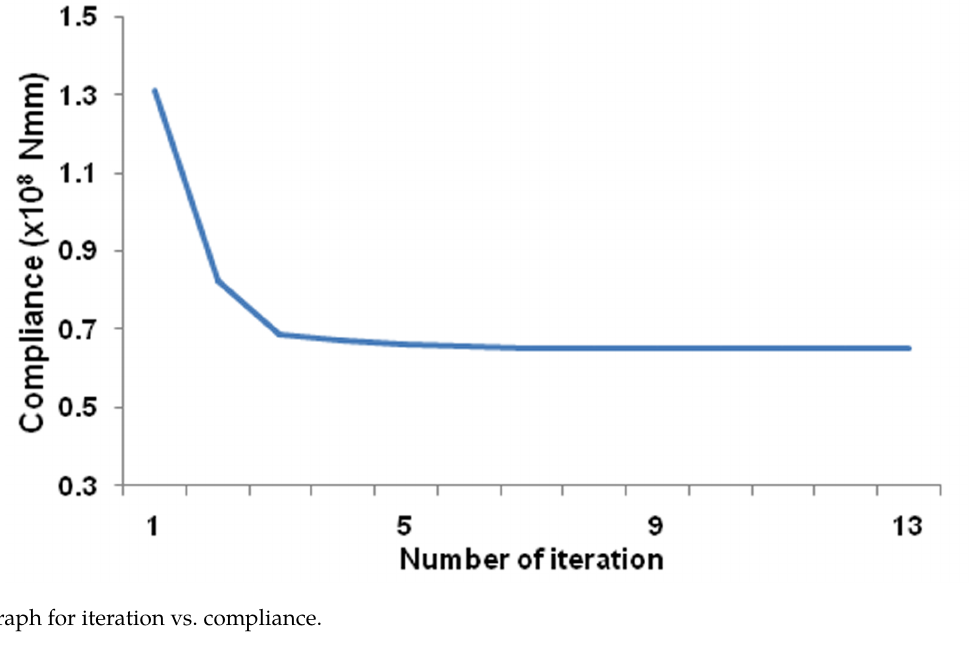
Figure 5: Optimum topology of the fork end of a knucle joint.